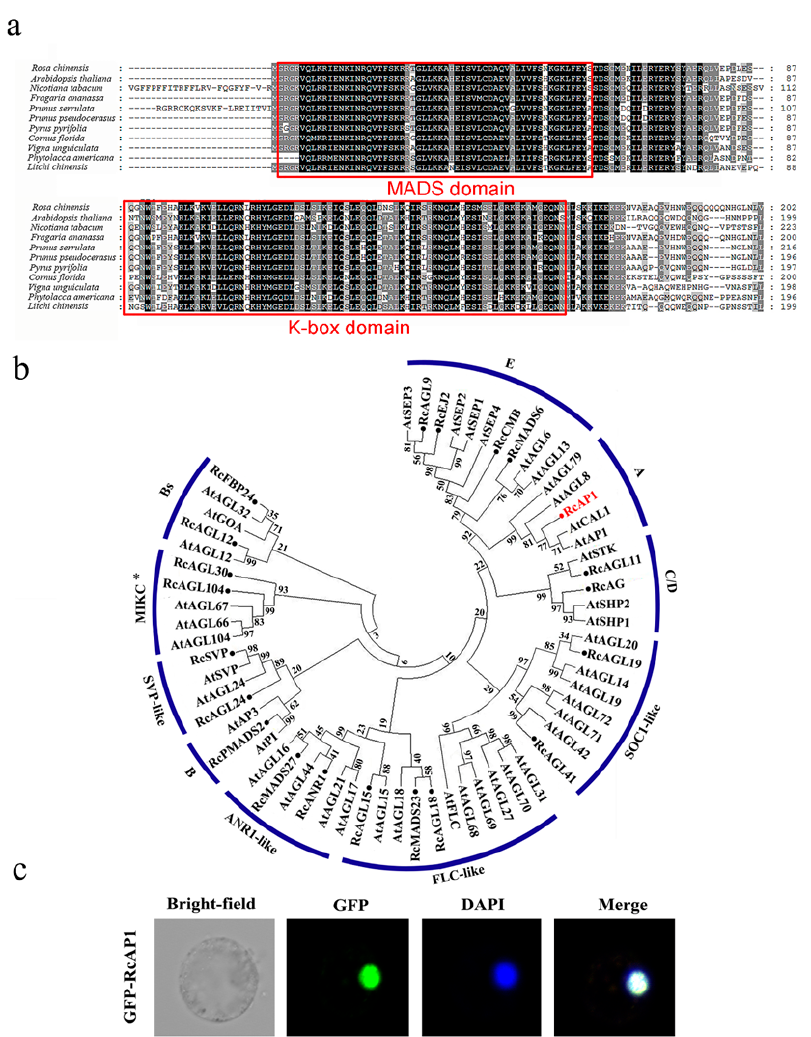
Figure 1. Bioinformatic analysis of RcAP1 ( a ) Multiple sequence alignment of deduced amino acid sequences encoded by RcAP1 and other AP1 genes from diverse species. Identical conserved residues are indicated in black, while partially conserved residues are presented in gray. The dotted lines indicate gaps to maximize the alignment. The conserved MADS and K-box domains are framed in red. ( b ) Phylogenetic analysis of Rosa chinensis and A. thaliana type II MADS-box proteins. A total of